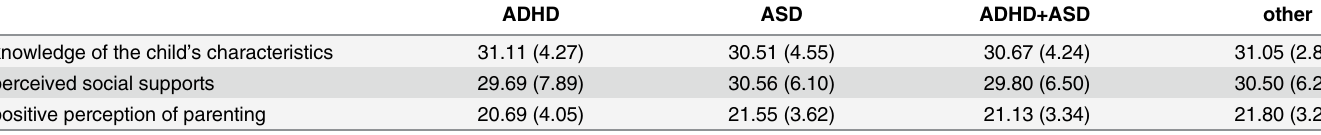
Table 6. Means (standard deviations) of sum scores of each subscale in diagnostic groups (N =